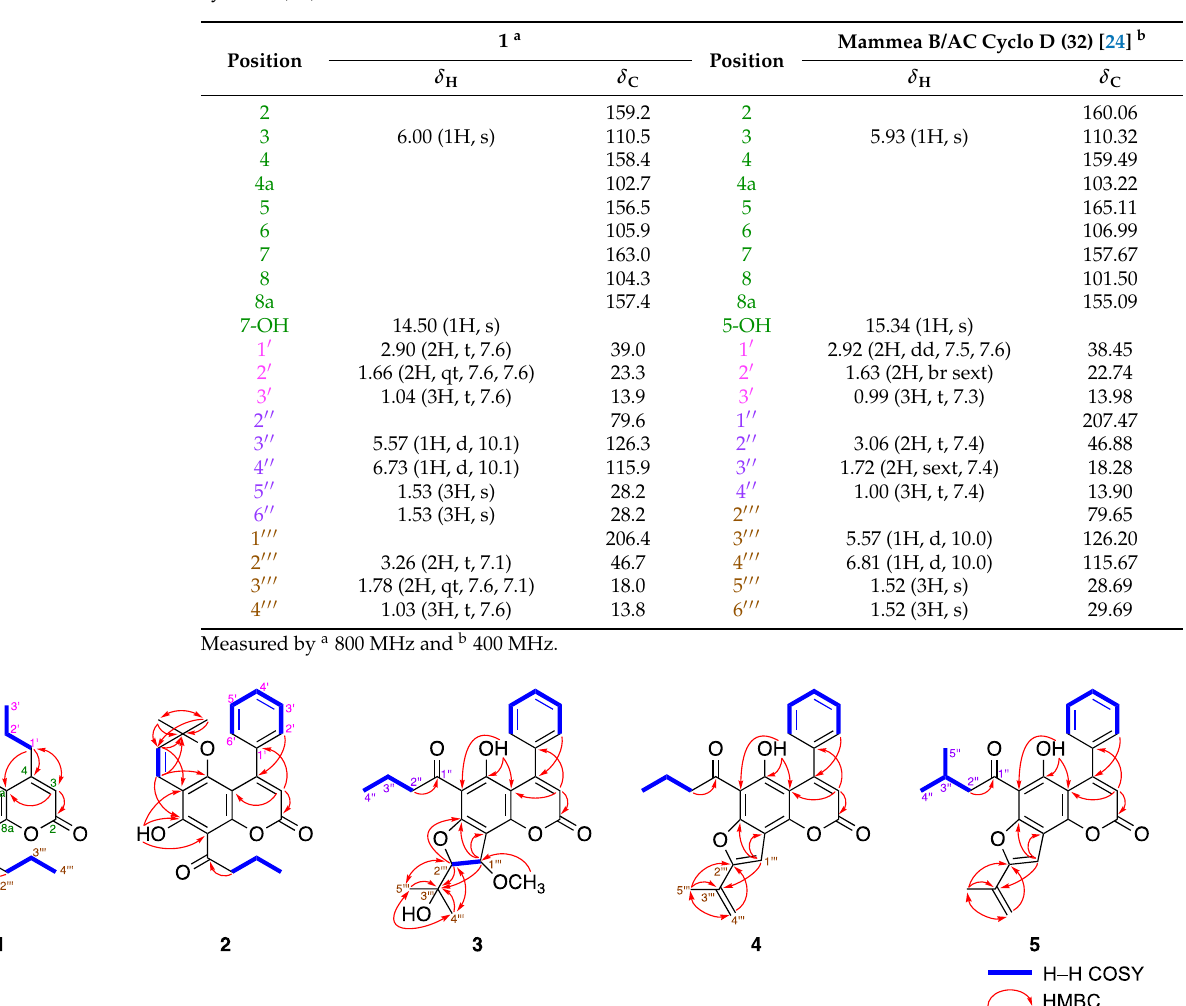
Table 1. 1 H and 13 C NMR spectroscopic data (CDCl 3 ) of mammeasins K ( 1 ) and mammea B/AC cyclo D ( 32 ).